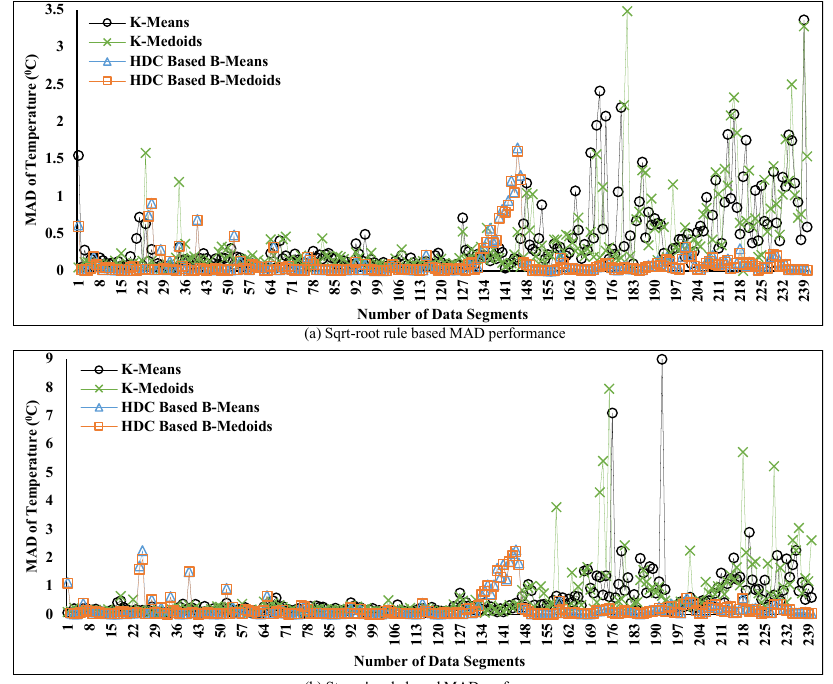
Figure 10. Performance comparison of proposed HDC-based B-means and B-medoids with conventional K-means and K-medoids versus the number of data segments. ( a ) Mean absolute deviation (MAD) versus square-root rule (K = 11); ( b ) MAD versus Sturge’s rule (K =